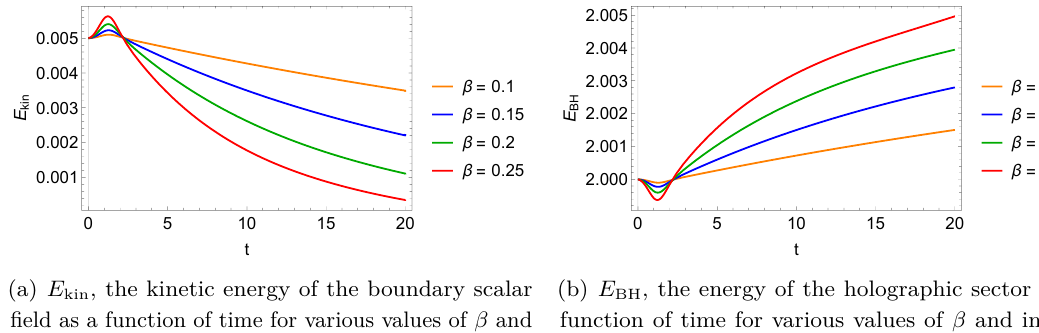
Figure 16 . The kinetic energy of the boundary scalar field and that of the holographic sector as a function of time for various values of β and initial conditions set by (4.17). The sum is conserved. Higher values of β lead to larger energy extraction from the black brane by the boundary scalar field but then the energy is returned back to the black brane irreversibly and completely at a higher rate. The time t max at which the boundary scalar field attains its maximum energy E max is independent of β . Thus the qualitative features are exactly like in the case of the initial condition (4.16) shown in figure